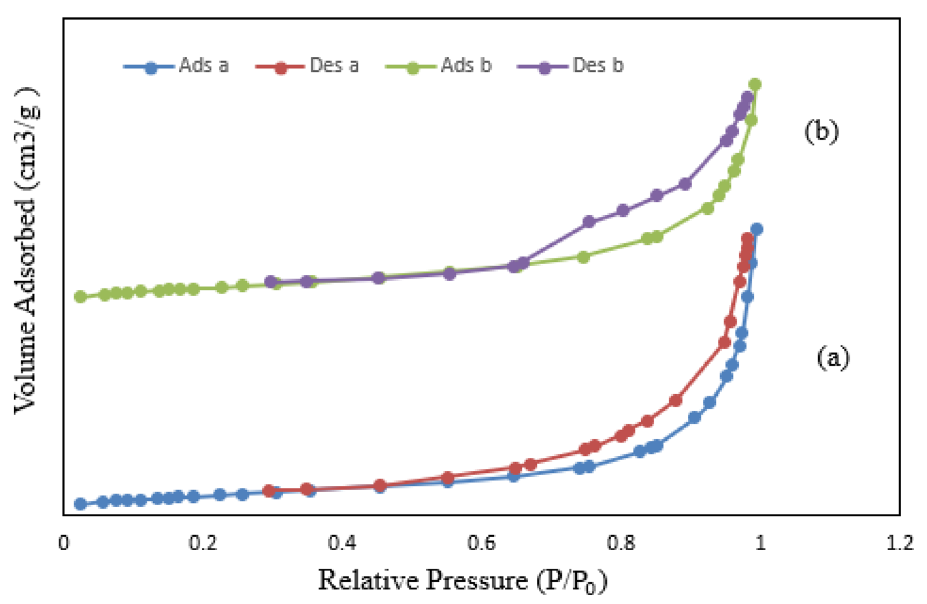
Figure 5. Nitrogen adsorption–desorption isotherms for ( a ) T1 ‒ Z1/CS ( b ) T1 ‒ Z1/CS1 ‒